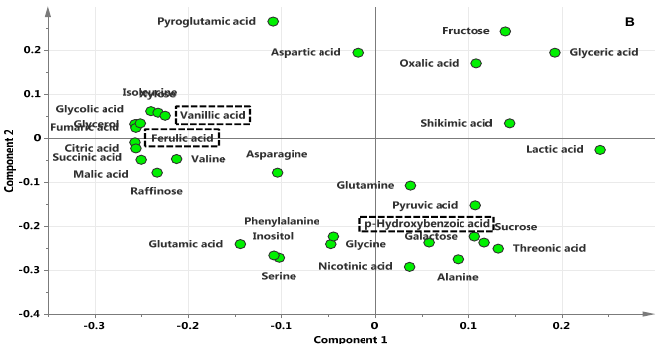
Figure 1. Scores ( A ) and loading plots ( B ) of principal components 1 and 2 of the PCA results obtained from polar metabolite data on different radish cultivars. Secondary metabolite was marked by a dotted box.